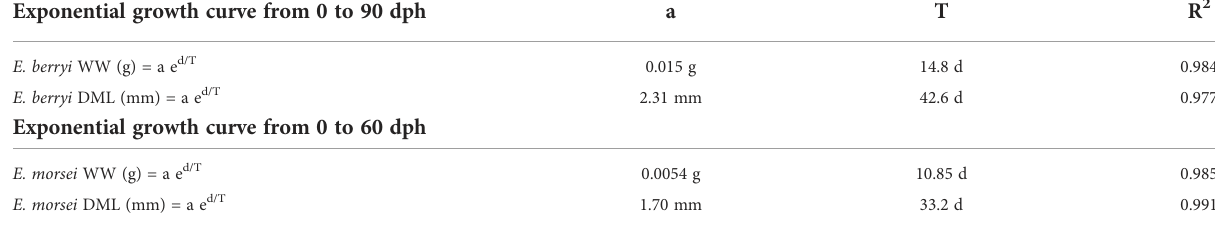
TABLE 1 Exponential growth curve equations for E. berryi 0-90 days post hatching (dph) and E. morsei 0-60 dph. Exponential growth curve from 0 to 90